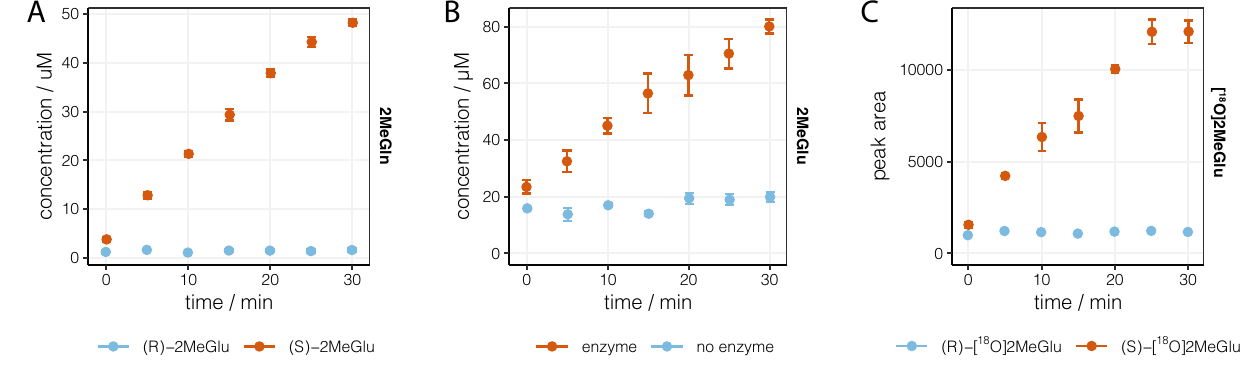
Figure 3. ( A ) Stereospecific conversion of 2MeGlu enantiomers by human glutamine synthetase. Reaction was performed with 10 mM substrate and 5 ng/mL enzyme in the presence of 10 mM ATP, 20 mM MgCl 2 , 40 mM NH 4 Cl, 25 mM 2-mercaptoethanol in 100 mM imidazole pH 7.0 buffer 18 . ( B ) Conversion of rac-2MeGln by human glutaminase GLS1. Reaction was performed with 10 mM substrate and 5 ng/mL enzyme in phosphate pH 7.4 buffer 19 . ( C ) Relative concentrations of ( R )- and ( S )-[ 18 O]2MeGlu generated in the GLS1 hydrolysis assay. Data are shown as mean ± SEM, n = 3.